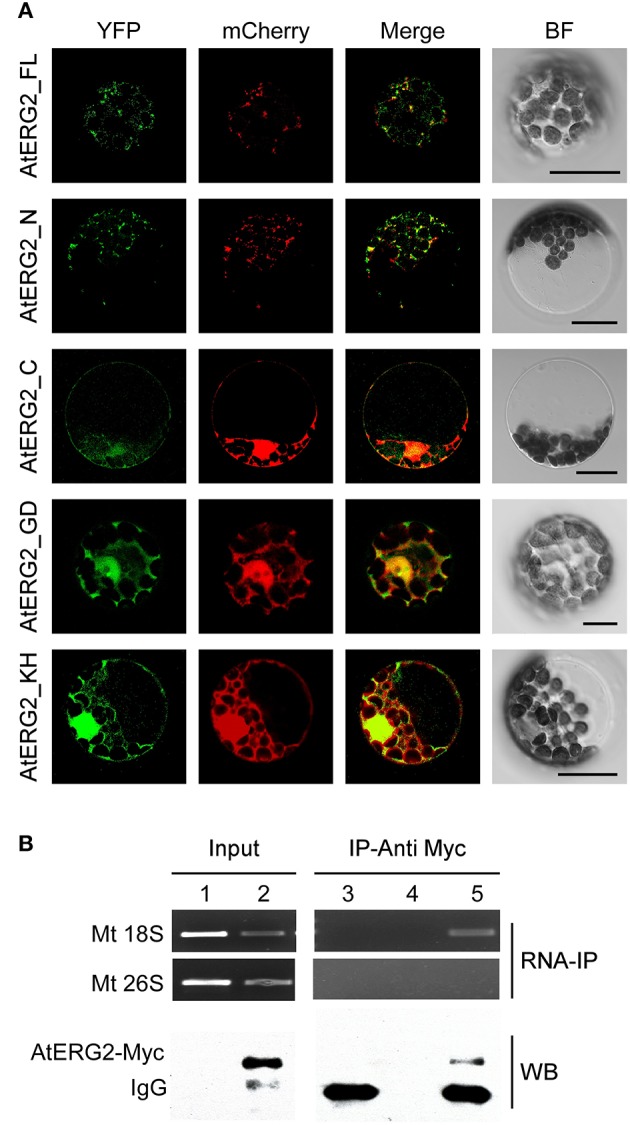
AtERG2 is localized in mitochondria and associated with mitochondria 18S RNA. (A) Localization of various truncated AtERG2 constructs in Arabidopsis mesophyll cells. The full-length AtERG2 (AtERG2_FL-YFP) and AtERG2 N-terminal part (AtERG2_N-YFP) were co-transformed with mCherry-labeled mitochondria marker; AtERG2 C-part (AtERG2_C-YFP), AtERG2 GTPase domain (AtERG2_GD-YFP), and AtERG2 KH domain (AtERG2_KH-YFP) co-transformed with mCherry-labeled cytoplasm marker. All images in this figure were obtained from one optic section. Scale bars are equivalent to 20 μm. The schematic of different AtERG2-eYFP constructs were shown in Figure S3. (B) RNA immunoprecipitation (RNA-IP) assays (top) showing the interaction between AtERG2-MYC and Mt 18S RNA in Arabidopsis were performed with (Lane 3 and Lane 5) or without (Lane 4) MYC antibody followed by RT-PCR detection. Mt 28S RNA served as a negative control (Lane 1 and Lane 2). The Western blot (WB, bottom) indicates the protein level in the transgenic plants, which was detected prior to the RNA-IP assay.